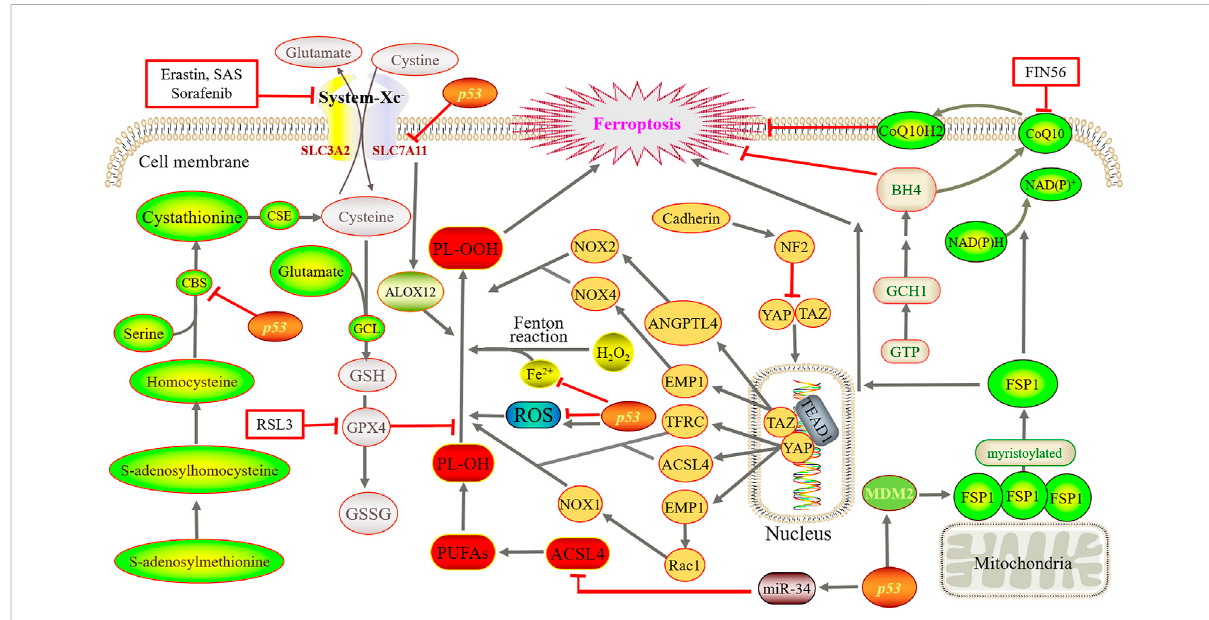
Main regulatory mechanisms of ferroptosis. Iron directs the Fenton reaction and induces large accumulation of ROS. Cystine is converted to cysteine for the synthesis of GSH. Then, GPX4 converts GSH to GSSG and reduces PL-OOH to PL-OH, thereby blocks the lipid peroxidation chain reaction. Using methionine as a sulfur donor, intermediate homocysteine, serine and cystathionine are converted into cysteine by the catalysis of CBS and CSE, simultaneously producing GSH. YAP and TAZ are abnormally activated, and bind to the TEAD after dephosphorylation. GCH1 overexpression promotes the generation of BH4. FSP1 oxidizes the terminal octadecylation modi fi cation of protein N to mediate lipid peroxidation. Simultaneously,FSP1catalyzestheregenerationofubiquinoneandentersthecirculation.Bysuppressing TFR1,ZIP14,ACSL4, SLC7A11andCBS, p53 reduce or increase ROS as well as transactivate